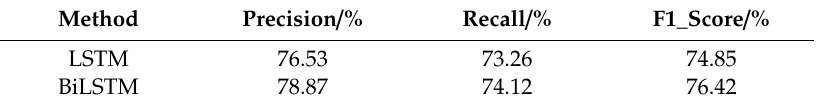
Table 5. Comparison of experimental results of LSTM model and BiLSTM model.